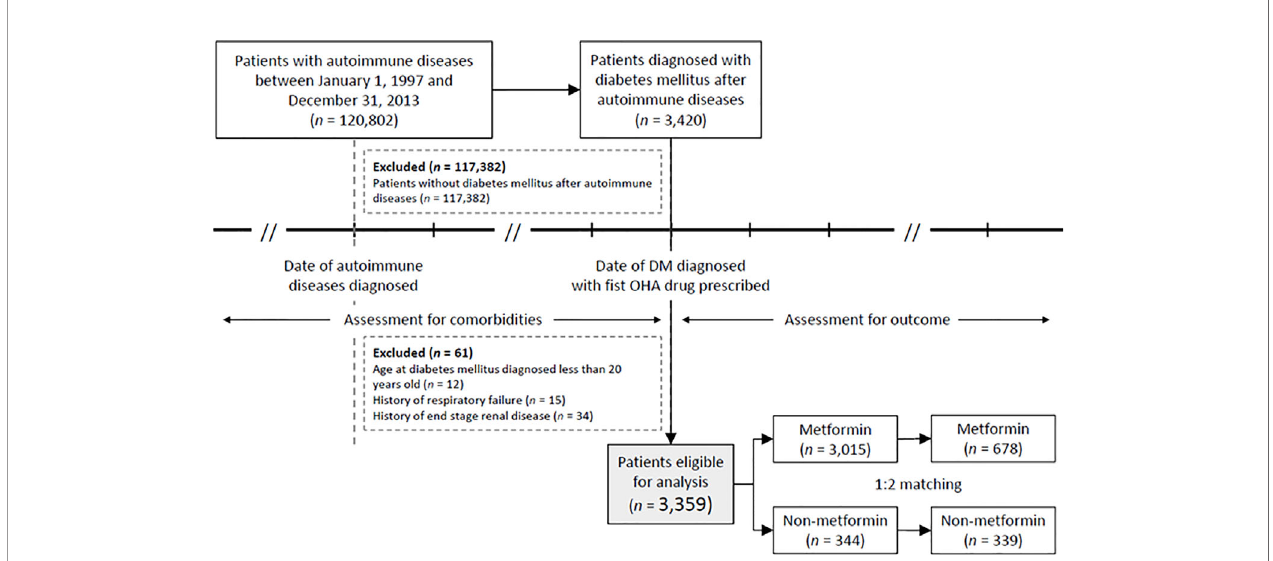
FIGURE 1 | Study design and patient inclusion